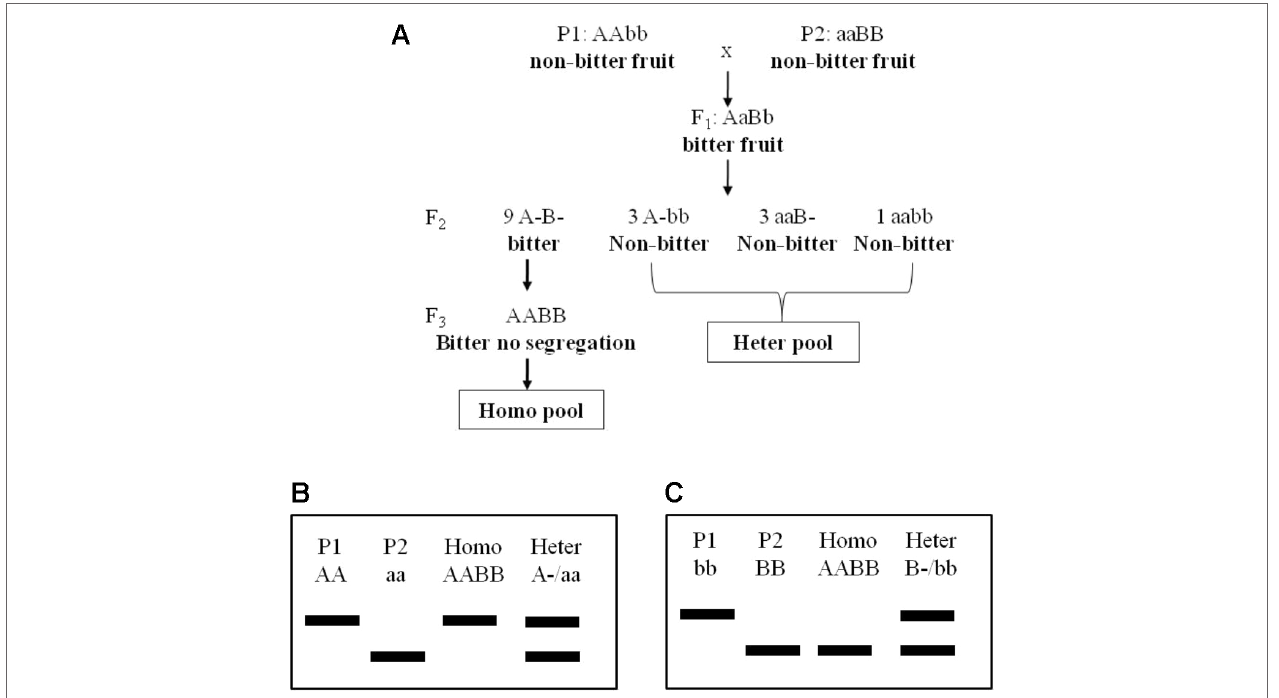
FIGURe 1 | The genetic model of fruit bitterness in the F 2 population (a) and advanced BSA method using in this study (B , C) . BSA, bulked segregant analysis.